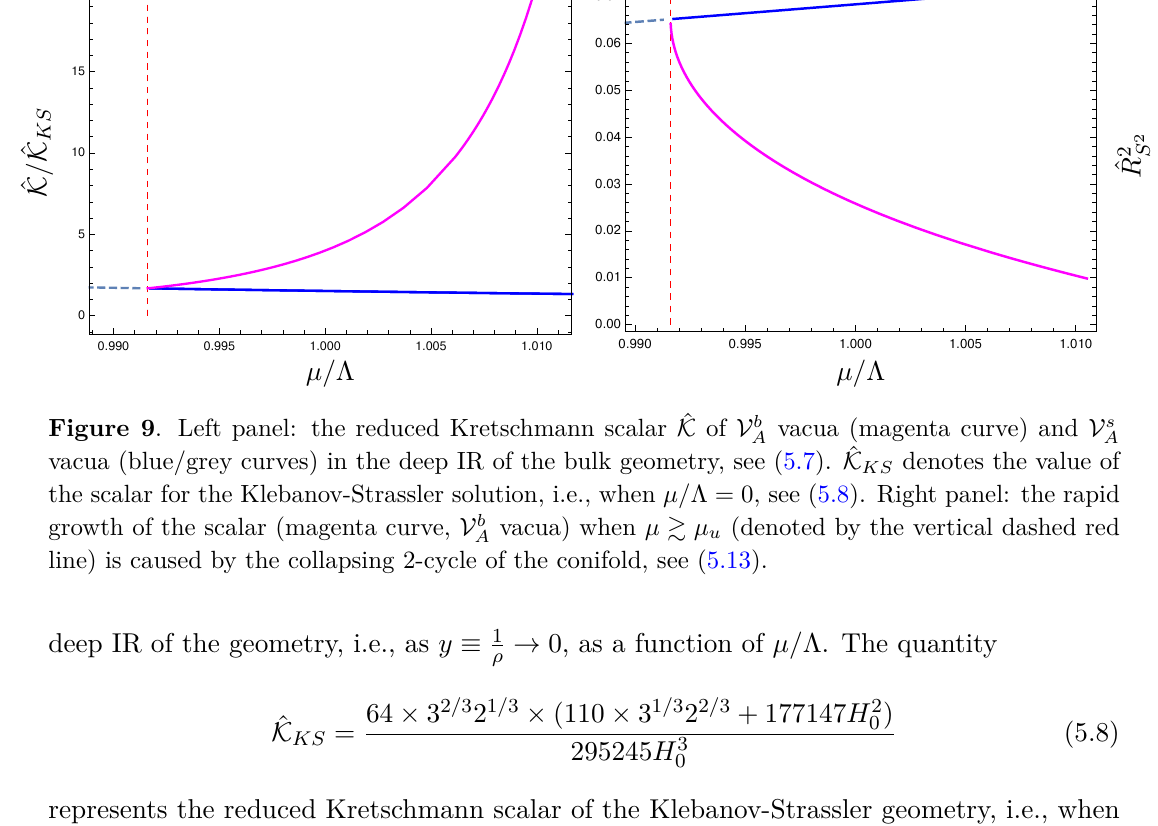
Figure 9 . Left panel: the reduced Kretschmann scalar ˆ vacua (blue/grey curves) in the deep IR of the bulk geometry, see (5.7). ˆ the scalar for the Klebanov-Strassler solution, i.e., when µ/ Λ = 0, see (5.8). Right panel: the rapid growth of the scalar (magenta curve, line) is caused by the collapsing 2-cycle of the conifold, see